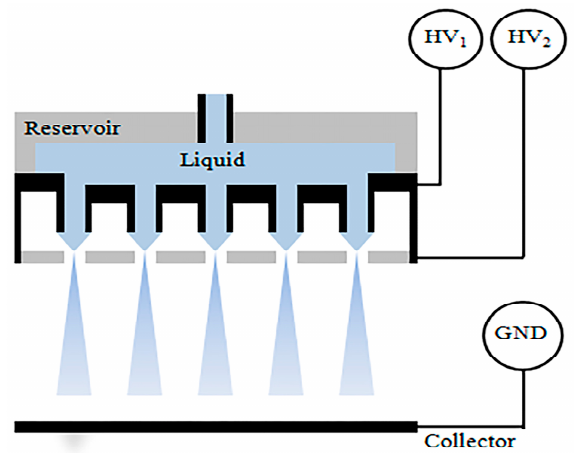
Figure 2. Multiplexed electrospray setup (Adapted from [24] ) .